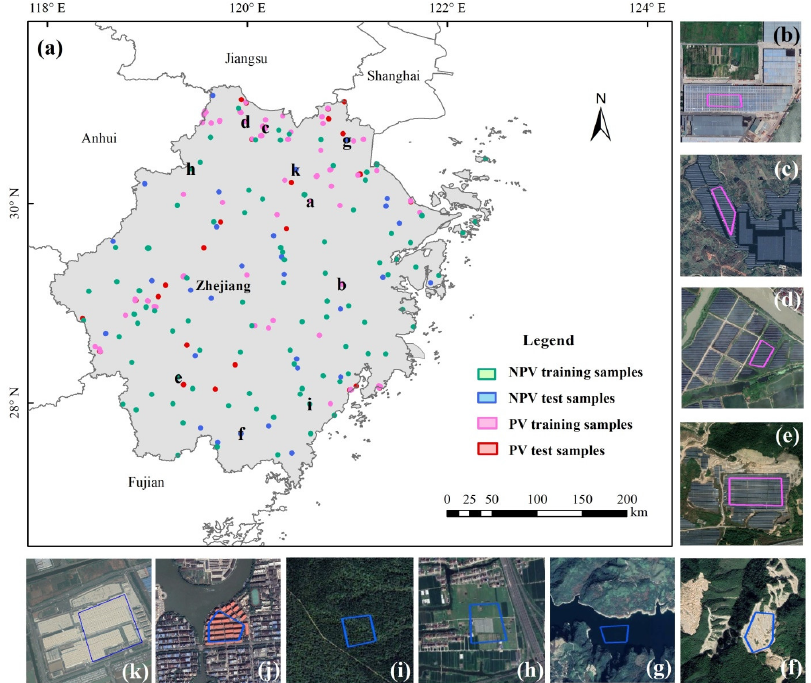
Figure 4. ( a ) The distribution of training and test samples for PV and NPV objects in Zhejiang Province, ( b – k ) are examples of the PV and NPV samples.